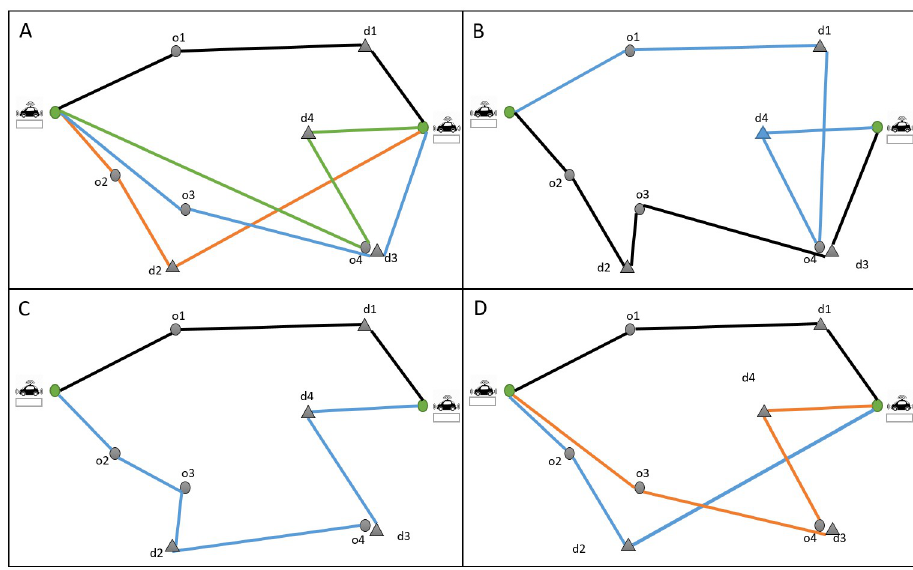
Fig 3. Feasible routes for the